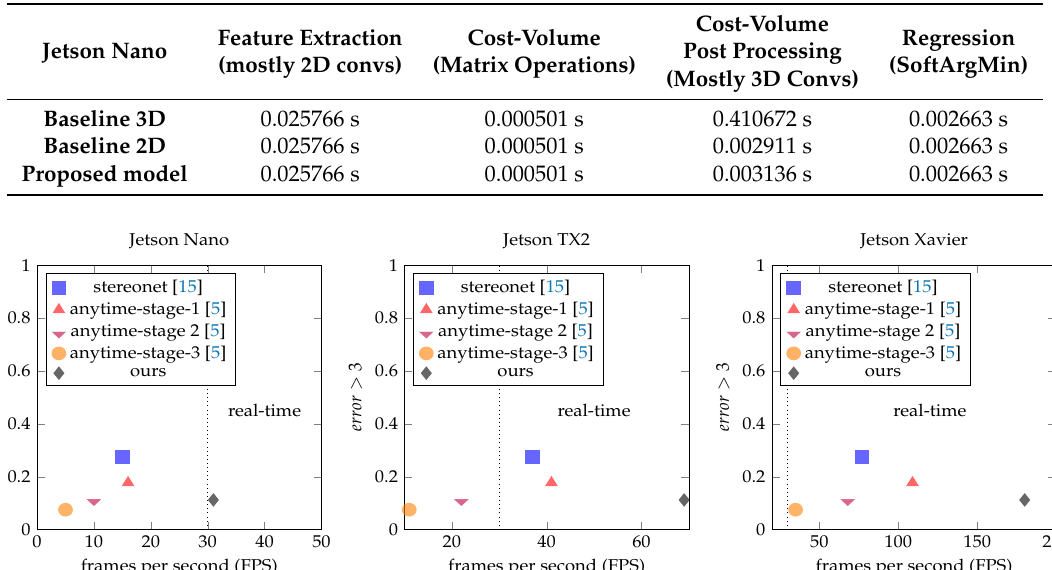
Table 8. Runtime performance of baseline 3D, baseline 2D, and the proposed model in the Jetson Nano. All models share the same architecture for the feature extraction, cost-volume, and regression steps. The cost-volume postprocessing architecture is different in all the models. All models are optimized as in Section 5.